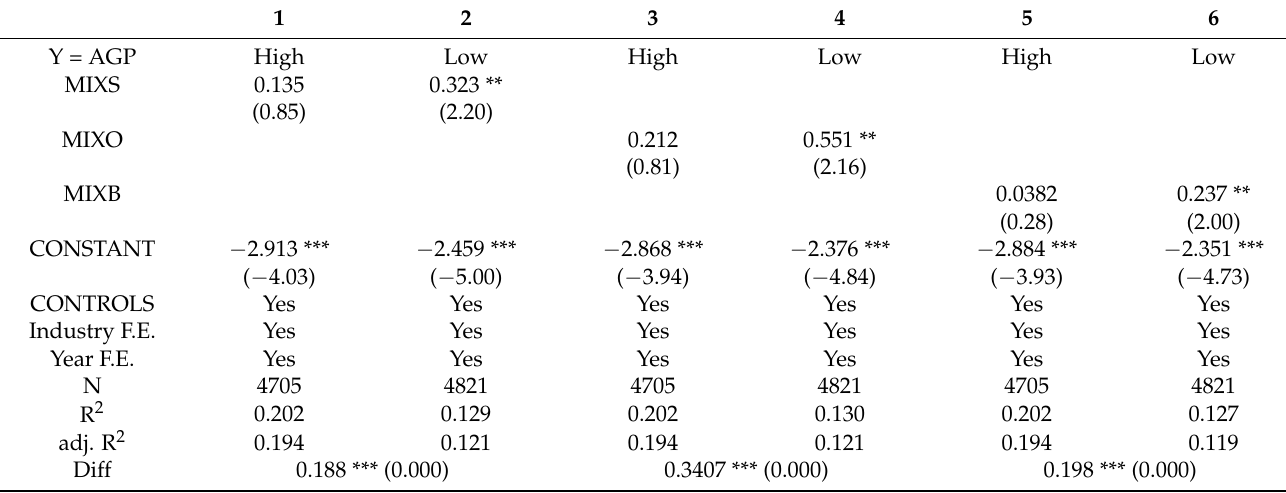
Table 12. The relationship between mixed-ownership reform and green innovation of SOEs under different marketization